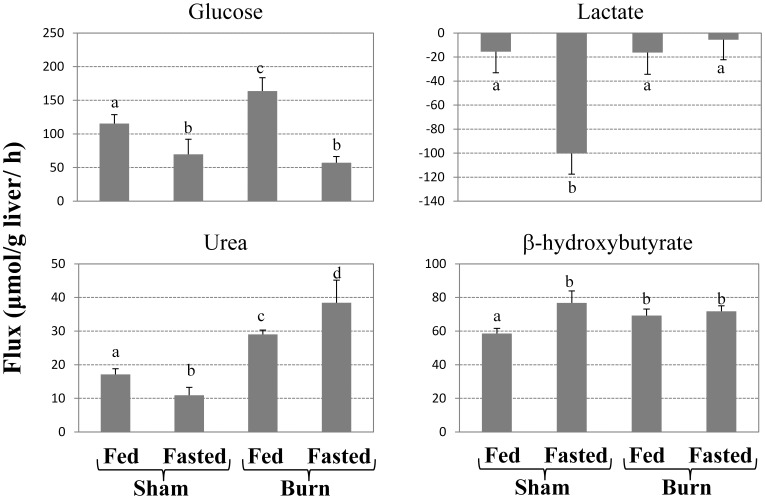
Average glucose, lactate, urea and β-hydroxybutyrate fluxes in perfused livers.Bars above and below indicate net production and uptake, respectively. Data shown were obtained from the slope of linear fits of measured perfusate concentrations vs. time normalized to liver mass. Bars labeled with different letters are statistically significantly different (ANOVA, P<0.05; N≥3) from each other. For example, lactate secretion rates in Sham+Fed group (a), Burn+Fed group (a) and Burn+Fasted group (a) are not significantly different from each other, whereas Sham+Fasted (b) is significantly different from the other groups. Data shown are means±SD.